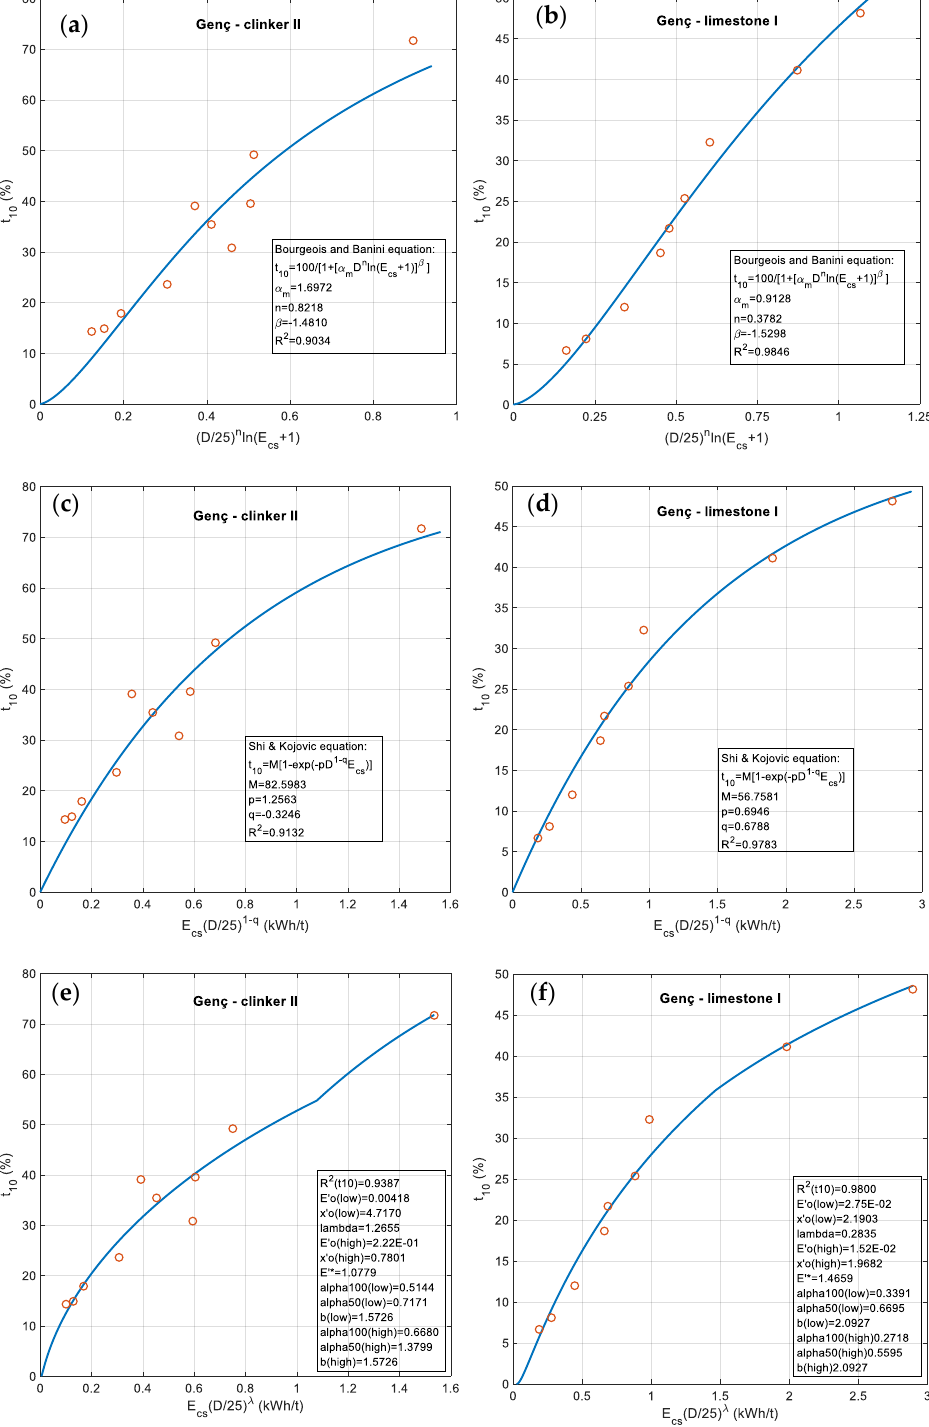
Figure 9. Breakage index plots for clinker II ( a , c , e ) and limestone I ( b , d , f ). Banini’s BIE ( a , b ), JK new BIE for 𝐸 𝑚𝑖𝑛 = 0 ( c , d ) and double fan BIE ( e , f ). For clinker II, the higher determination is the double fan ( 𝑅 2 = 0.9387); for limestone I it is Banini ’s ( 𝑅 2 = 0.9846).